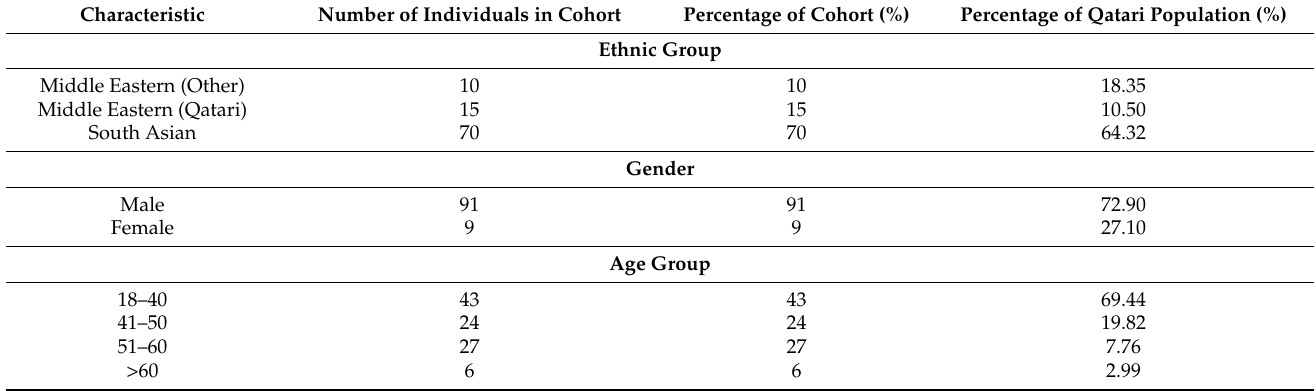
Table 4. Summary of the demographics of Cohort 3 and the Qatari population. Percentage of each ethnic group in Cohort 3, compared to the percentage of each ethnicity found in the Qatari population. Ethnicities that did not fall under the three broader ethnic groups were excluded from this table ( n = 5). Gender distribution in Cohort 3 compared to the gender distribution in the Qatari population. Age distribution in Cohort 3 compared to the age distribution in the Qatari population.